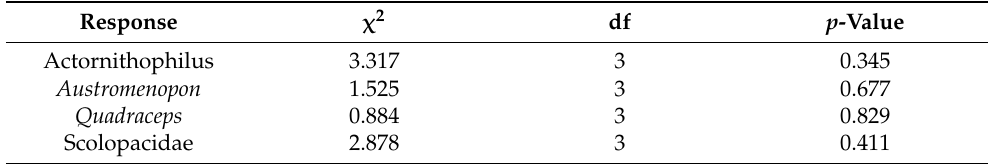
Table 7. Likelihood ratio test results for fitted model with flyway and host weight compared to null model (containing only the random effect).